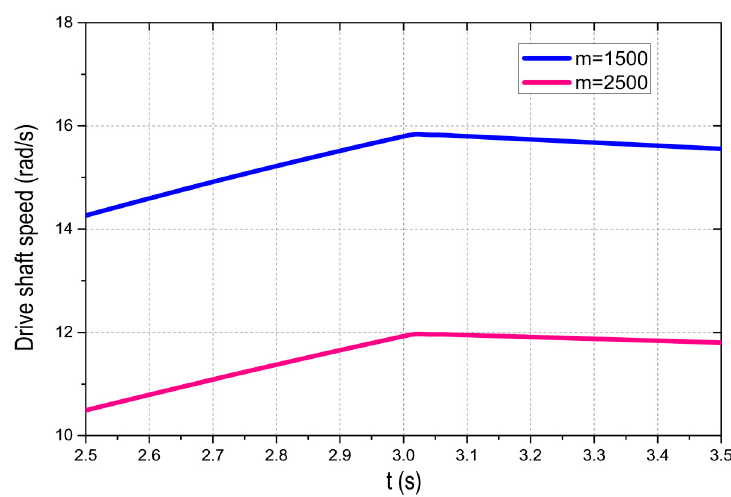
Figure A1. Motor speed oscillations.